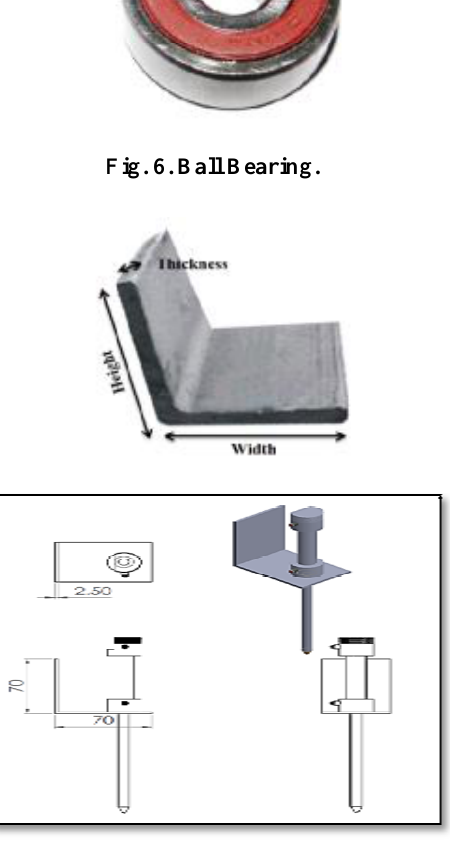
Fig. 6. Ball Bearing.